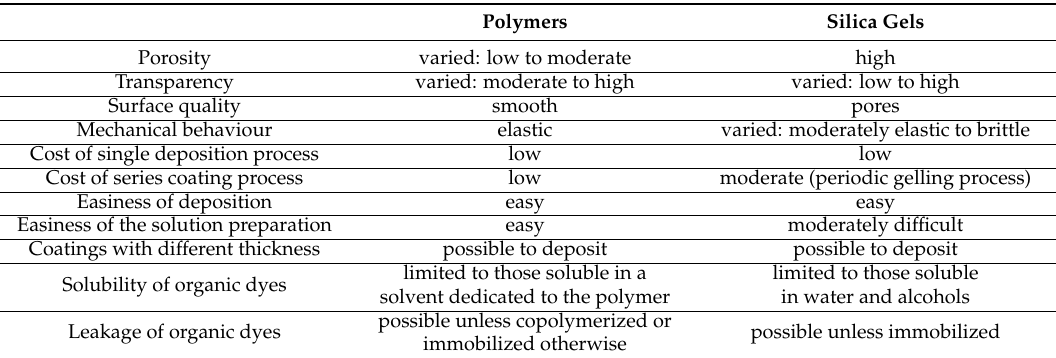
Table 1. Comparison of the most important properties of polymers and silica gels. Polymers Silica Gels Porosity varied: low to moderate varied: moderate to